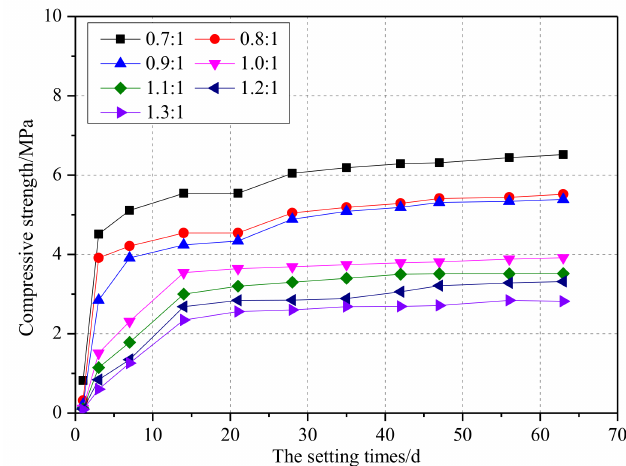
Figure 8. Strengths of filling materil specimens with di ff erent water–solid ratios and curing times. Reprint with permission [30]; Copyright 2016, Springer. Table 1. The elastic modulus of the filling materials with di ff erent water–solid ratios.